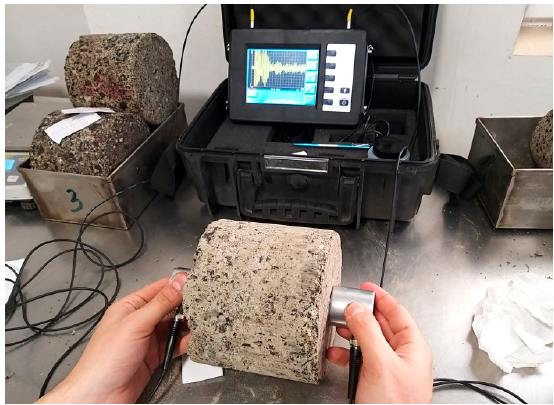
Figure 2. Testing the dynamic modulus of elasticity by ultrasound method. The time of travel of longitudinal waves was measured from the moment of sending a pulse from one side of the sample to its reception on the other side of the sample. The time of travel is denoted by T . Ultrasound speed ( V ) is determined by the Equation